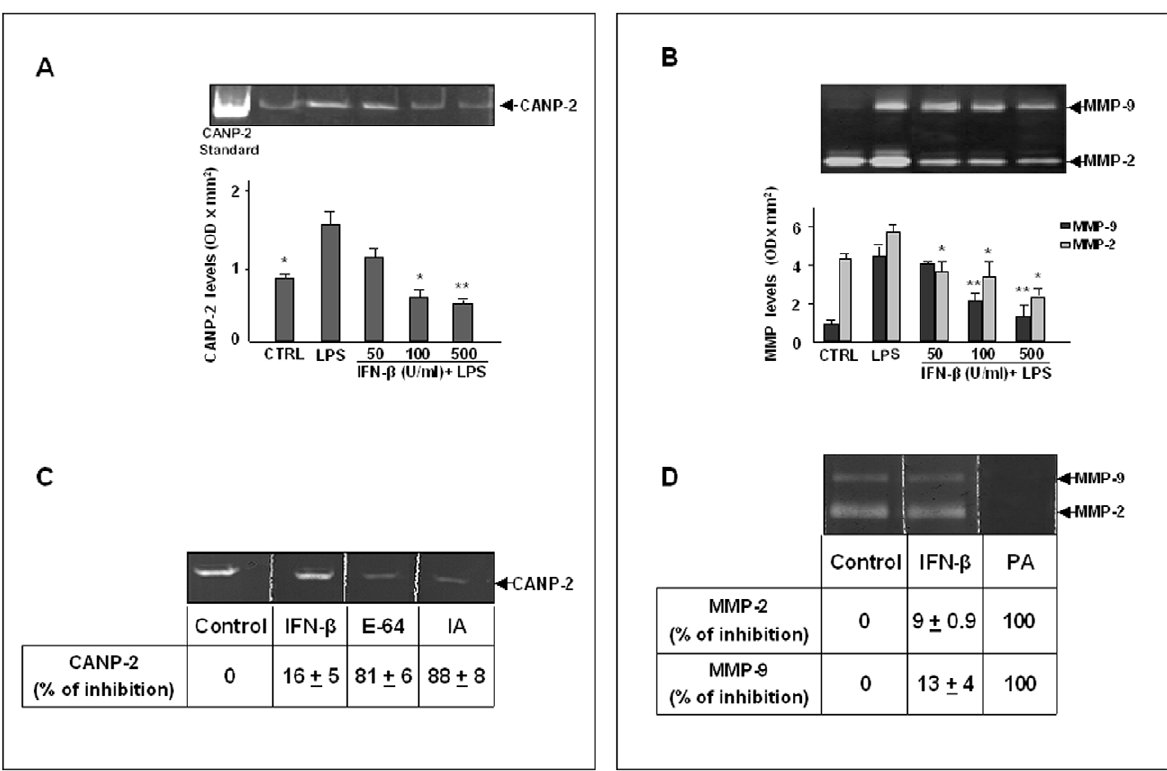
Figure 4. Effect of IFN- b treatment on CANP-2, MMP-2 and MMP-9 levels and activity. Primary astrocytes (1 6 10 5 cells/ml), incubated in serum-free DMEM, were treated with IFN- b at the indicated concentrations (U/ml) in the presence of LPS (10 m g/ml). After 24 h of incubation cell lysates and supernatants were prepared and subjected to casein- (A) or gelatin-zymography (B). The negative control (CTRL) was represented by non- activated and untreated cells. CANP-2 present in lysates was identified by comigration with 0.5 m g of CANP-2 standard. MMP-2 and MMP-9 were identified by their apparent molecular mass of 67 and 92 kDa, respectively, using pre-stained molecular weight markers (Bio Rad). Histograms show the quantitation of CANP-2, MMP-2 and MMP-9 levels, expressed as optical density (OD) 6 mm 2 , calculated after scanning densitometry and computerized analysis of gels. Results represent the mean 6 SD of three separate experiments performed with different cell populations. Statistically significant values different from positive control, represented by lysates or supernatants from LPS-activated astrocytes (LPS), are indicated with * (One-way Anova followed by Student – Newman – Keuls post hoc test; *P , 0.05; **P , 0.005). The effect of IFN- b on CANP-2 or MMP-2 and MMP-9 activity was also evaluated in a cell-free system. Purified standard CANP-2 (0.5 m g) was subjected to casein-zymography (C). Purified standard